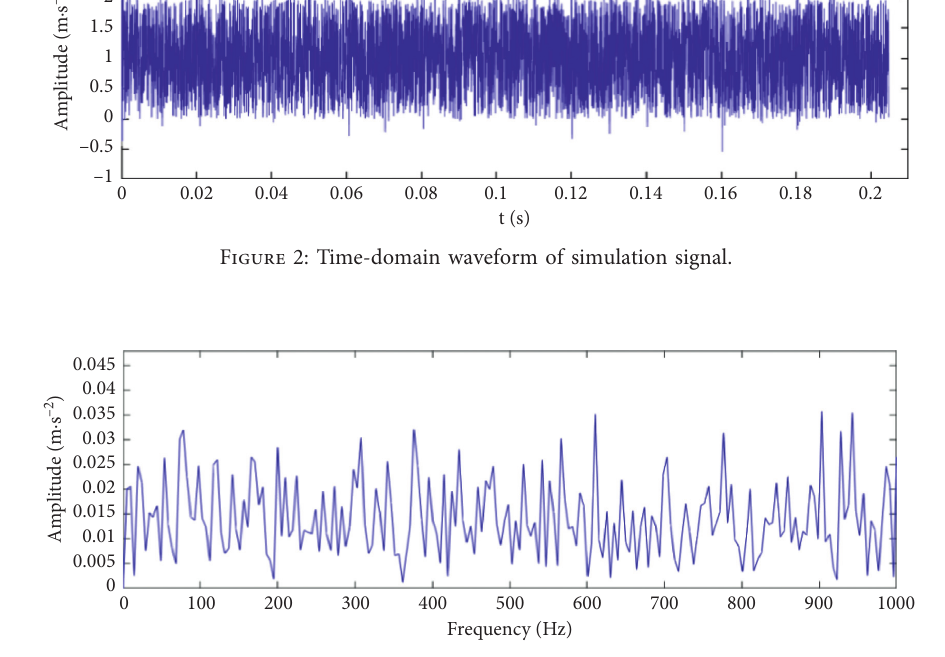
Figure 3: Hilbert envelope spectrum of simulation signal.